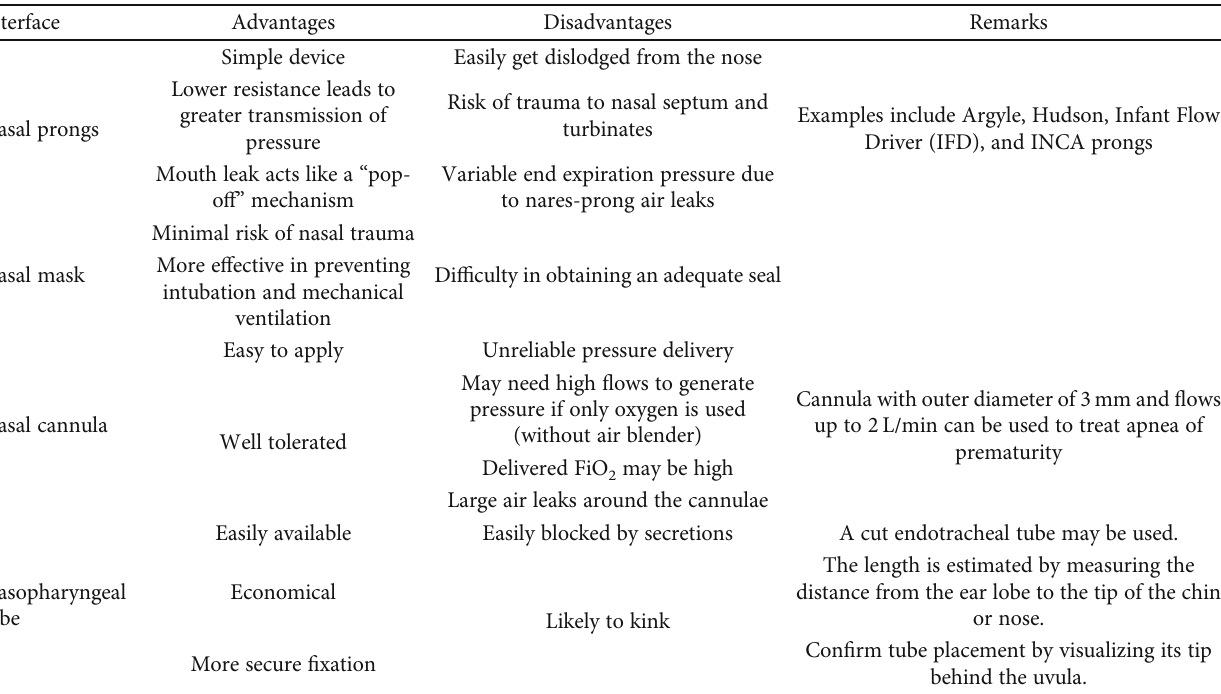
Table 2: Comparison of CPAP